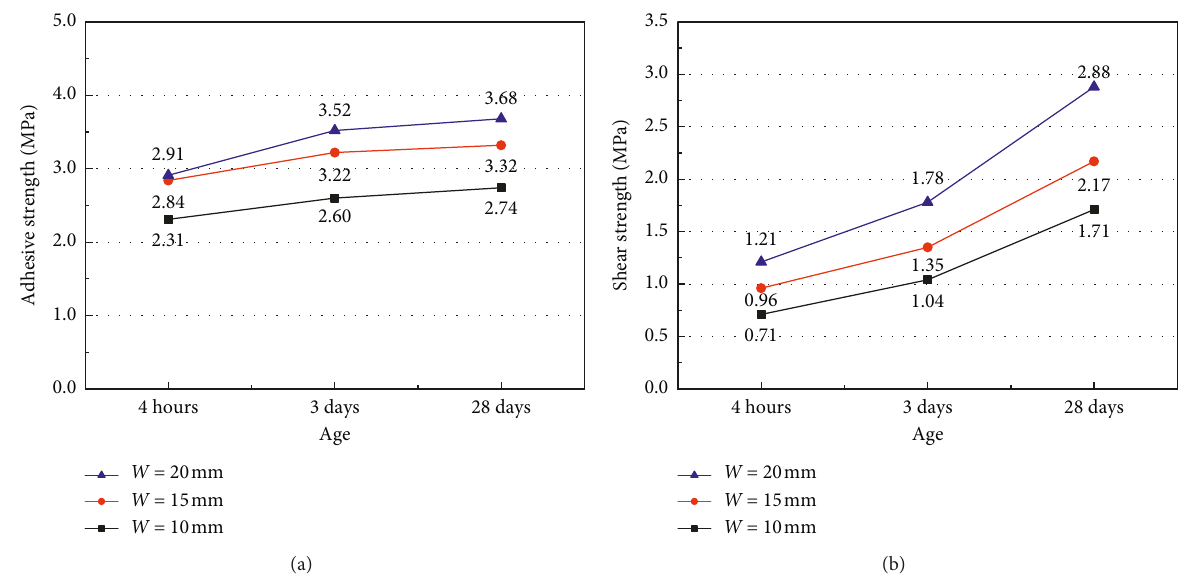
Figure 8: Test outcome of mortar. (a) Adhesive strength. (b) Shear